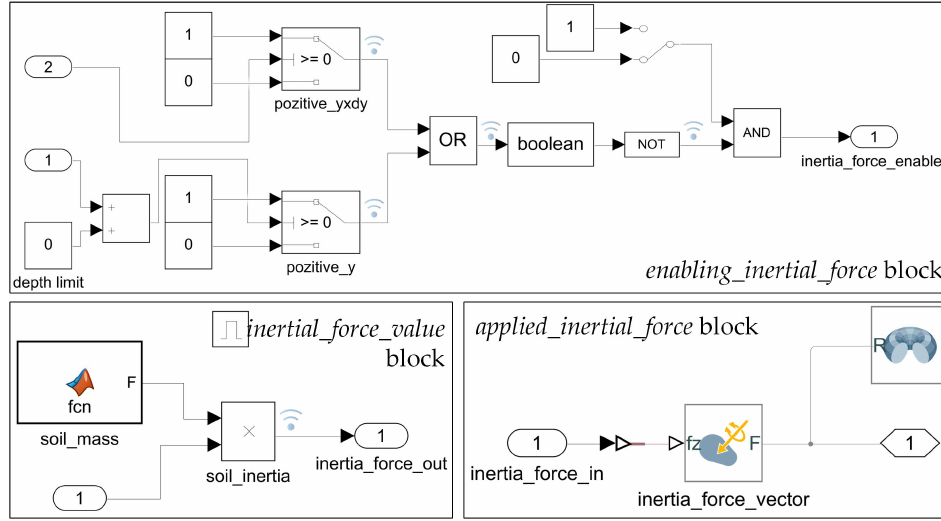
Figure 13. Blocks for calculating, enabling and applying the inertia force